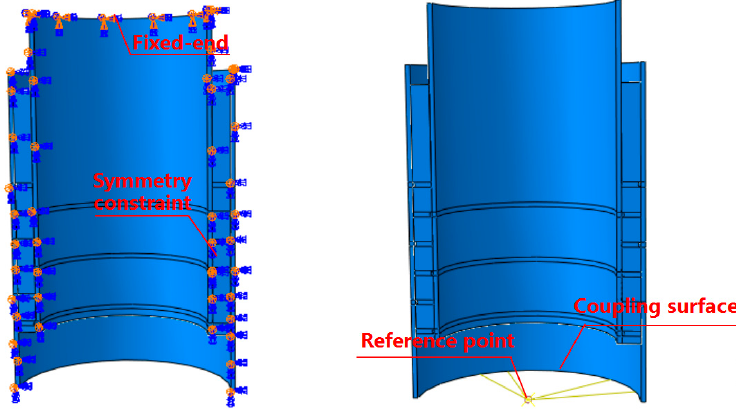
Figure 11. Model boundary conditions.